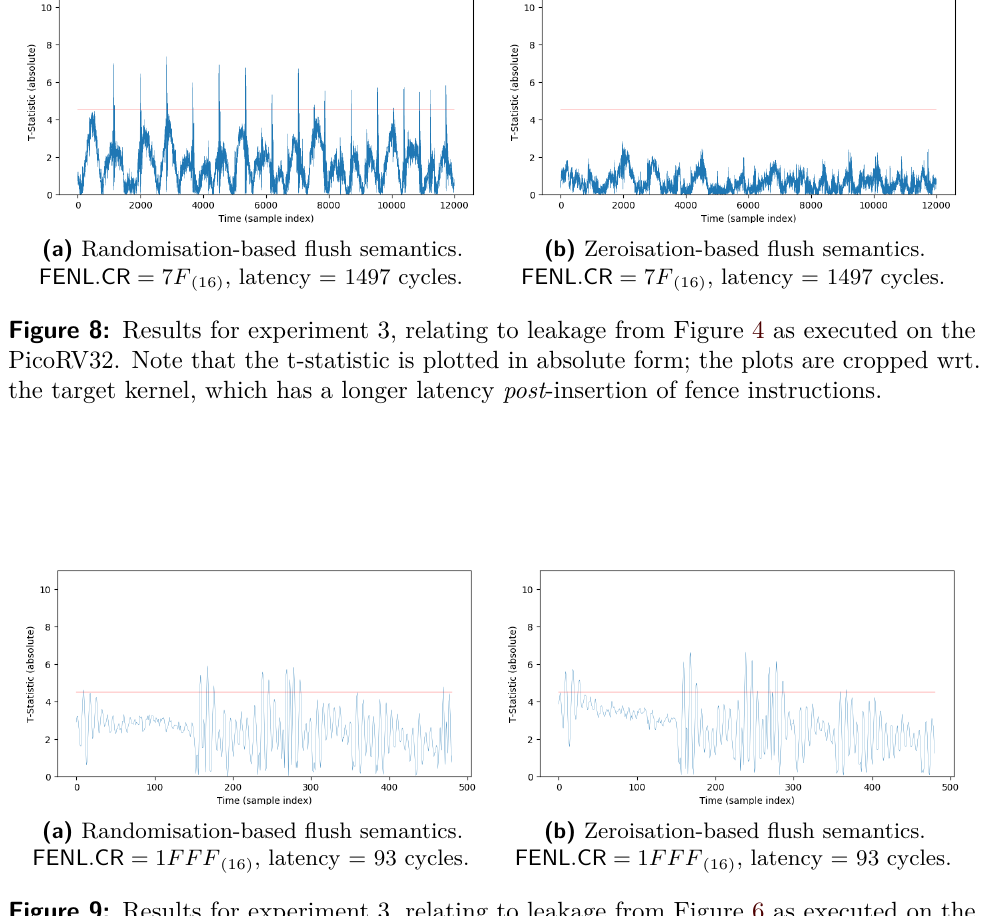
Figure 9: Results for experiment 3, relating to leakage from Figure 6 as executed on the SCARV core (bubbling variant). Note that the t-statistic is plotted in absolute form; the plots are cropped wrt. the target kernel, which has a longer latency post -insertion of fence instructions.